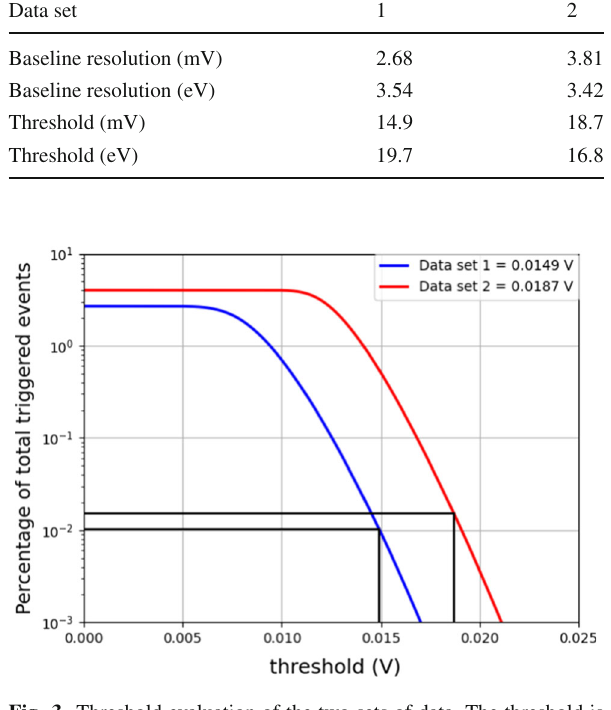
Fig. 3 Threshold evaluation of the two sets of data. The threshold is estimated with a function that gives the number of noise triggers for a given threshold (see [34] for details). The thresholds that have been calculated are 14.9 mV for data set 1 and 18.7 mV for data set 2.